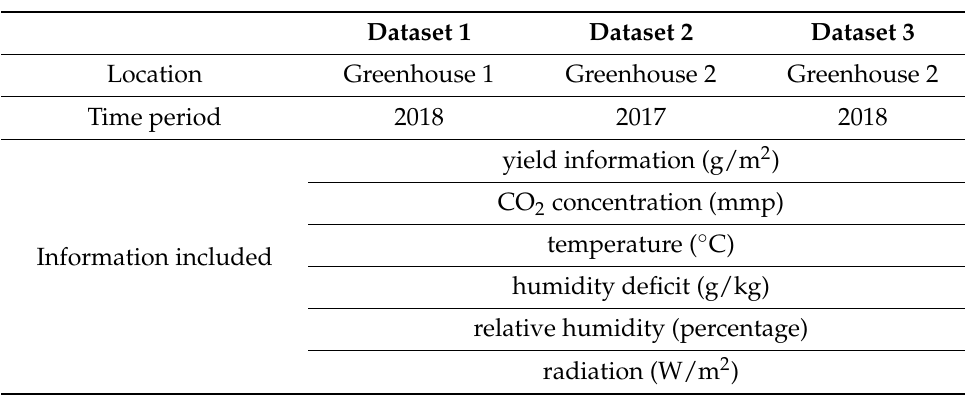
Table 1. Datasets